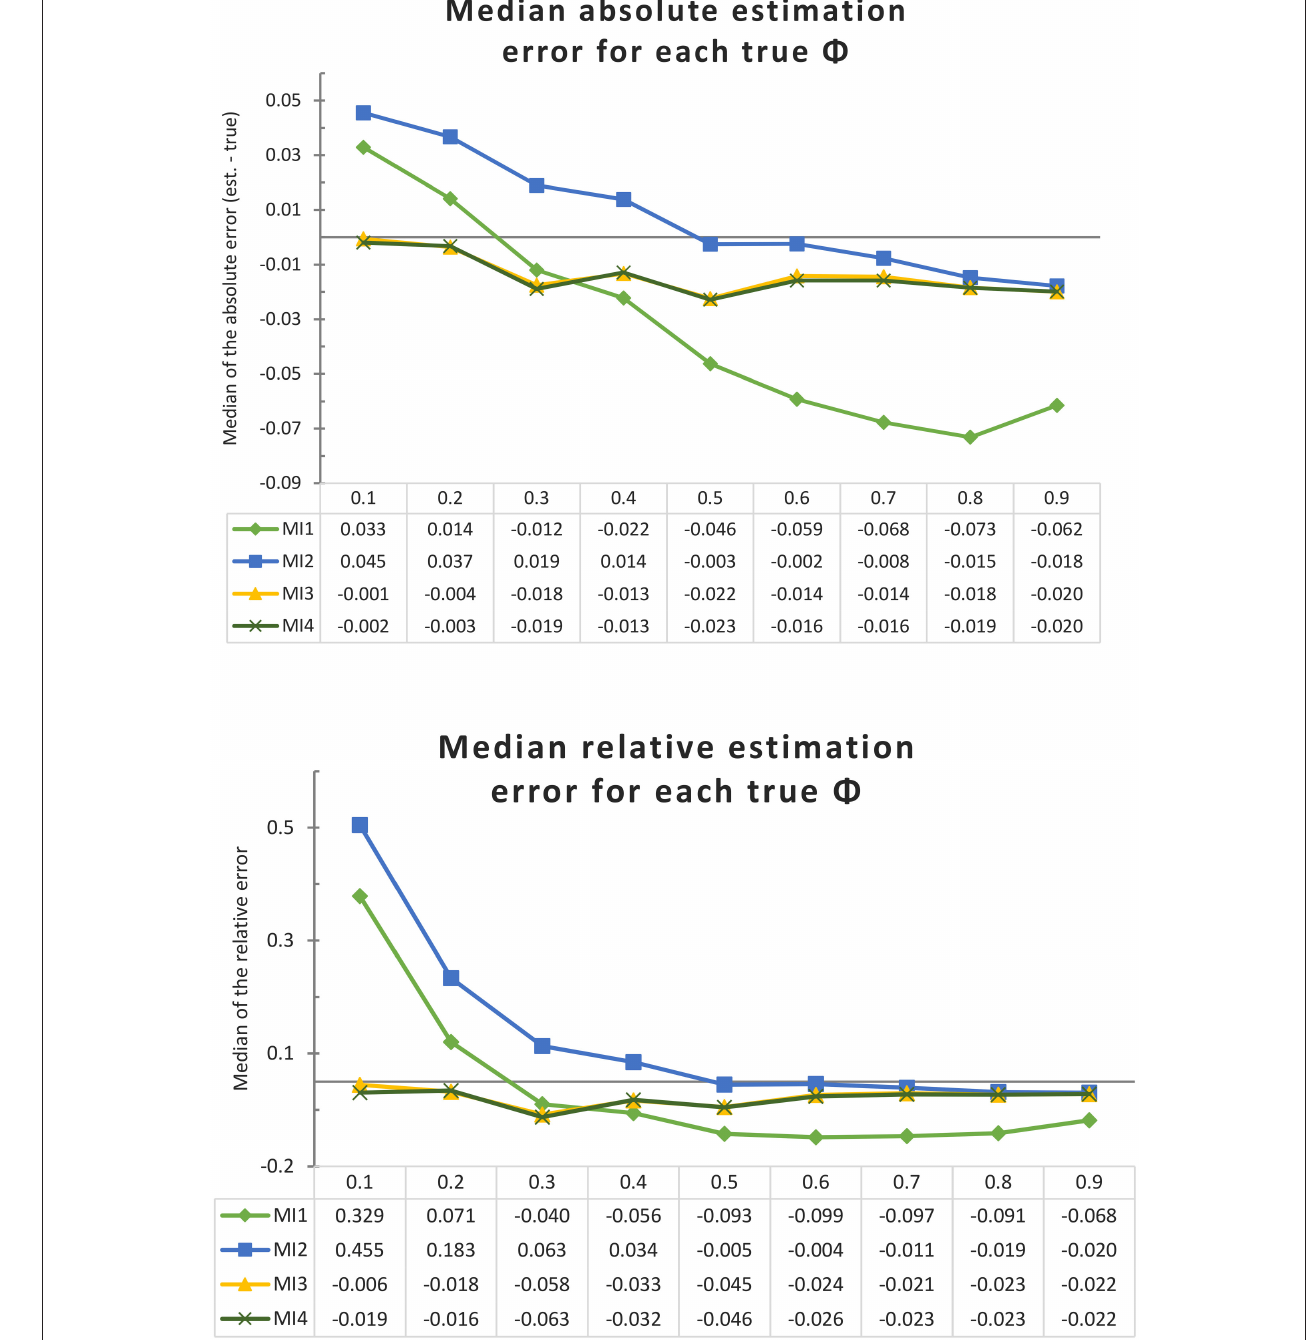
FIGURE 5 | Median absolute and relative estimation error, for each model implementation and true φ , over 1,000 shorter univariate time series (of 10 days each), with no minimum interval length. Each line represents a model implementation, and on the X-axis we have the nine different true values of φ